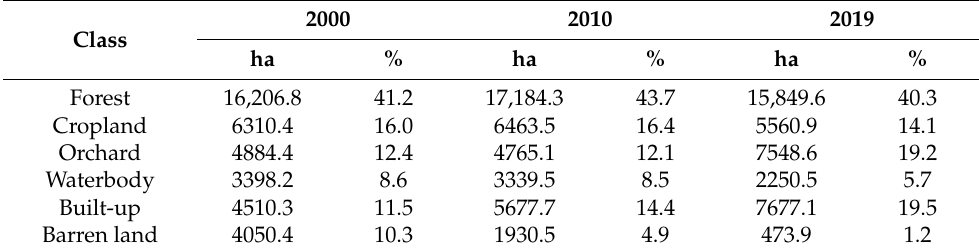
Table 5. Distribution LULC classes in Dong Trieu district from 2000 to